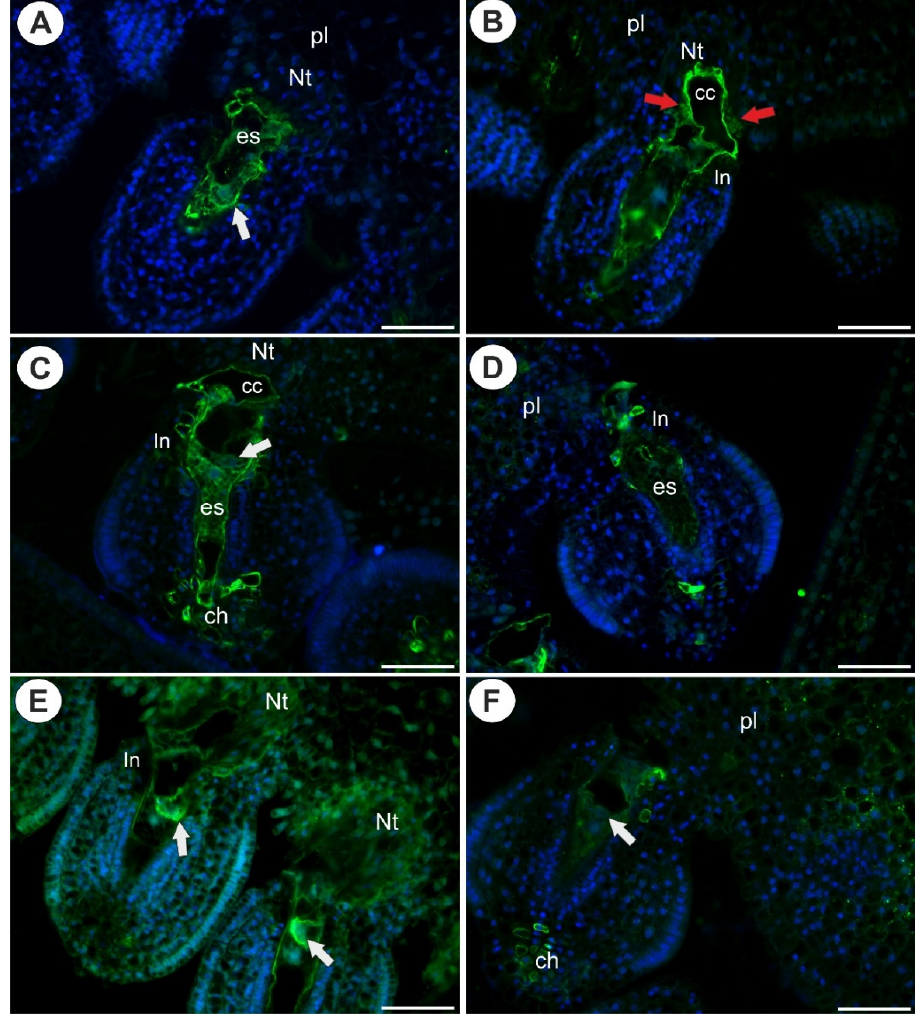
Figure 6. Arabinogalactan proteins detected in Utricularia nelumbifolia and Utricularia humboldtii after pollination but before fertilization. ( A , B ) Arabinogalactan protein (labeled with JIM13, green fluorescence) detected in U. nelumbifolia: placenta (pl), placenta nutritive tissue (Nt), embryo sac (es), integument (In), hypertrophied part of the central cell (cc), egg cell (white arrow), positive signal in the placenta epidermal cells (red arrows). ( C ) Arabinogalactan protein (labeled with JIM13, green fluorescence) detected in U. humboldtii: nutritive tissue (Nt), hypertrophied part of the central cell (cc), integument (In), embryo sac (es), chalaza (ch). ( D ) Arabinogalactan protein (labeled with JIM8, green fluorescence) detected in U. humboldtii: integument (In), placenta (pl), embryo sac (es). ( E ) Arabinogalactan protein (labeled with JIM14) detected in U. nelumbifolia : integument (In), nutritive tissue (Nt), egg cell (white arrow). ( F ) Arabinogalactan protein (labeled with JIM14, green fluorescence) detected in U. humboldtii : placenta (pl), chalaza (ch), egg cell (white arrow). All bars 50 µ